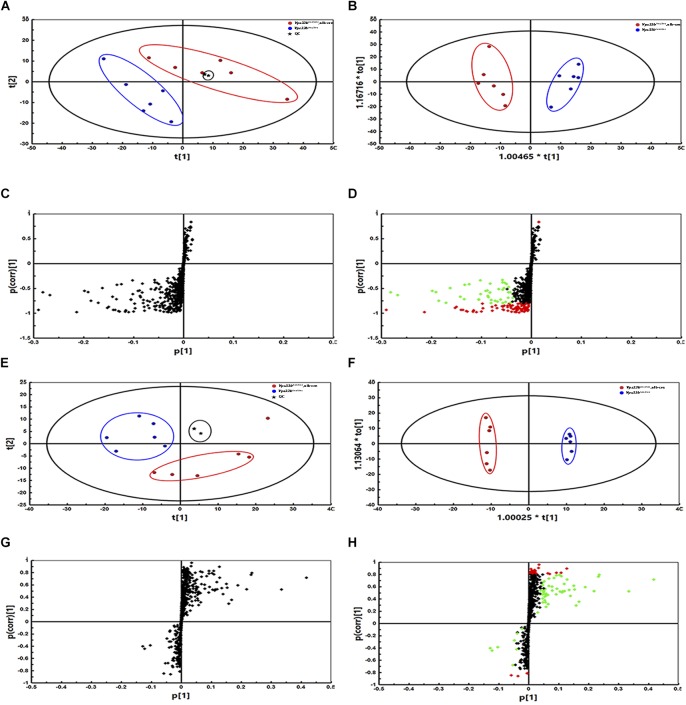
Principal component analysis, OPLS-DA score plot and s-plot of serum and liver lipid profiles in Vps33bflox/flox, alb-cre mice and Vps33bflox/flox mice. The PCA as well as OPLS-DA of serum (A,B) and liver (E,F) show a clear difference between the two groups (blue dots for Vps33bflox/flox mice, red dots for Vps33bflox/flox, alb-cre mice and black dots for QC control). The supervised multivariate analysis shows R2Y = 0.94 and Q2 = 0.877 in serum, while R2Y = 0.99 and Q2 = 0.498 in livers. s-plots (C,D,G,H) highlighted the possible calculated lipid components with p-value less than 0.05. [green dots represent VIP > 0.8, while red dots represent p(corr) < -0.6 or p(corr) > 0.6].